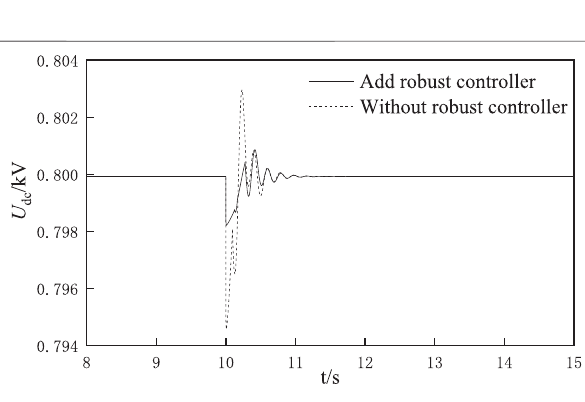
FIGURE10| DCbus voltage waveform when chopper K pp isperturbed.